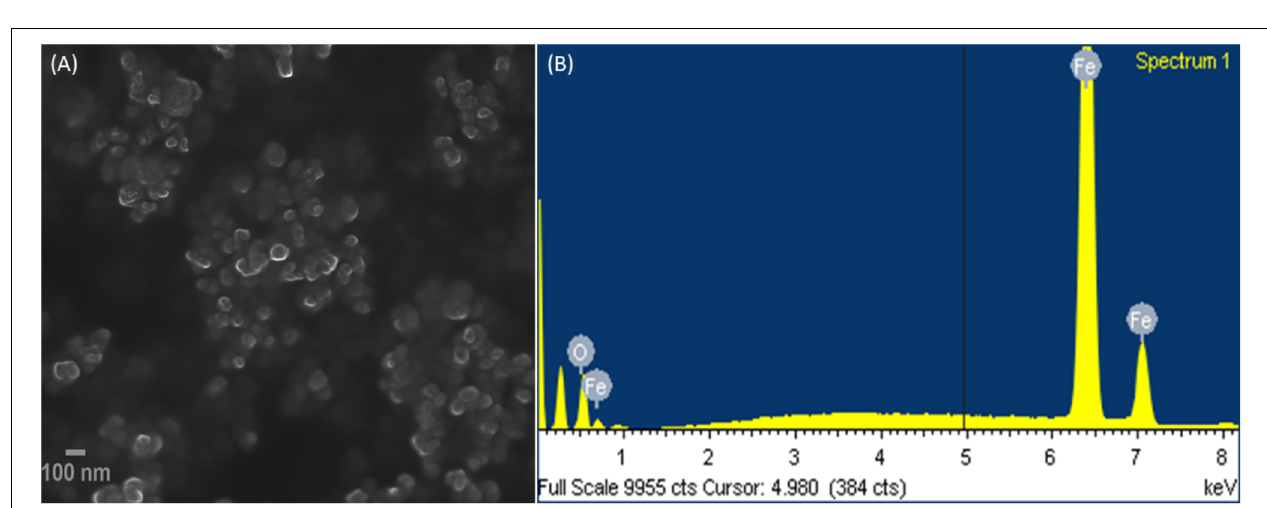
FIGURE 2 | (A) Field emission scanning electron microscopic (FESEM) images, and (B) EDX of IONPs.